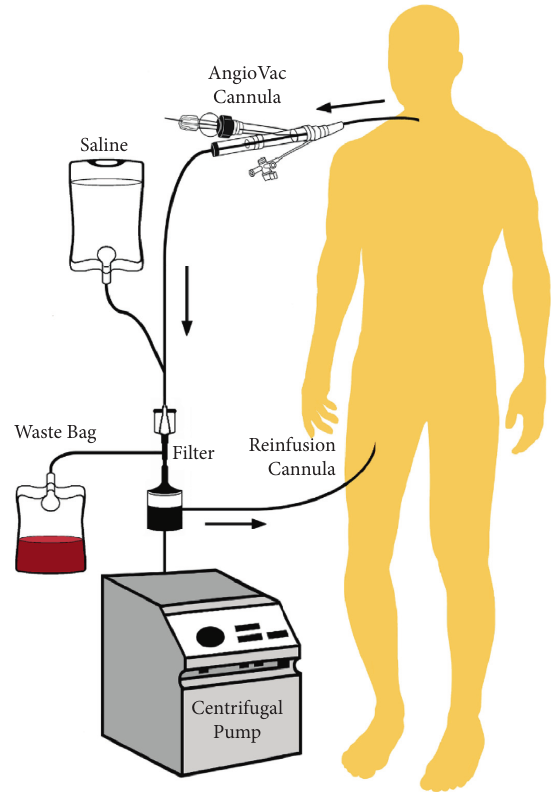
Figure 1: An overview of the AngioVac reperfusion system. The tip is inserted either via percutaneous or surgical cutdown at the internal jugular or femoral vein and connected to a suction-gen- erating bypass circuit. Blood is filtered and reinserted at the reinfusion